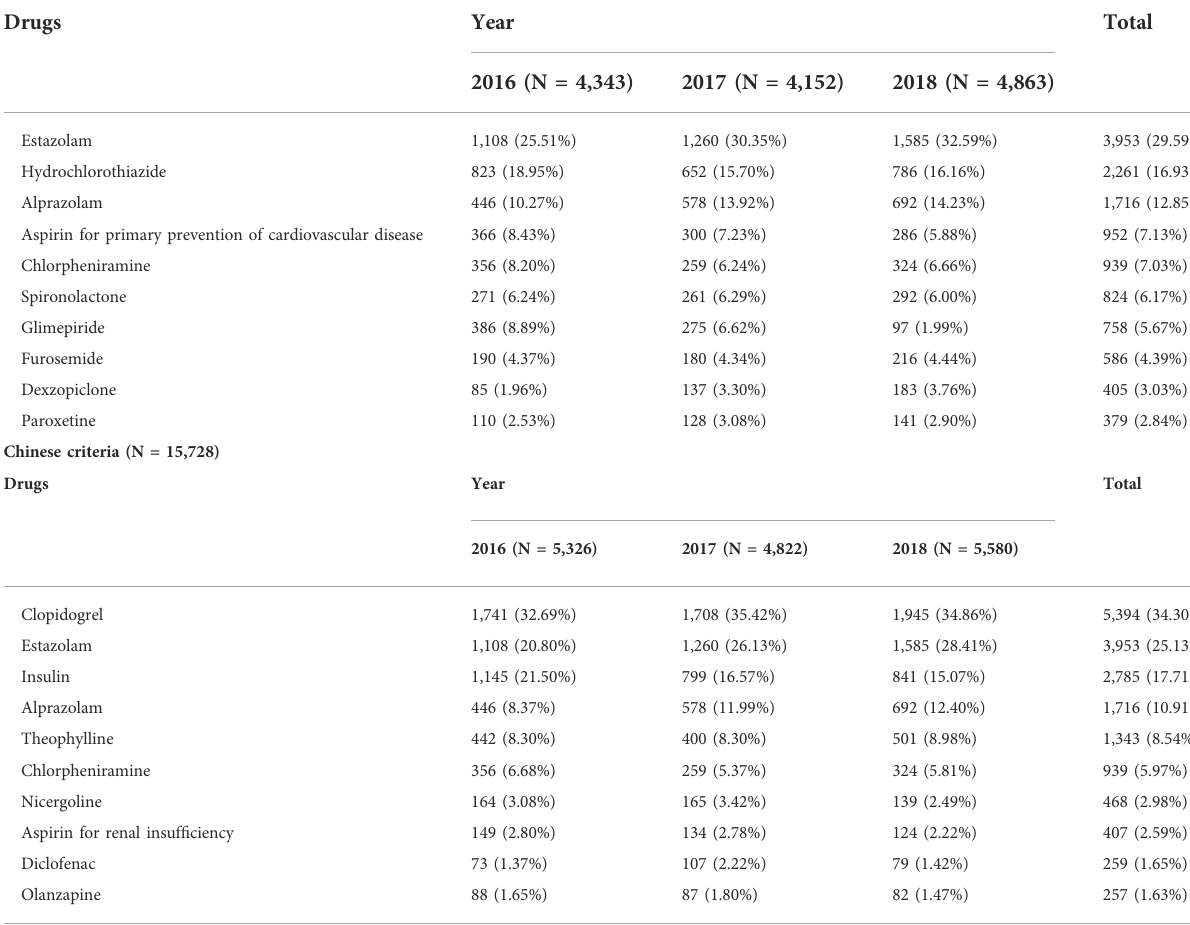
TABLE 3 Top ten PIMs based on the two